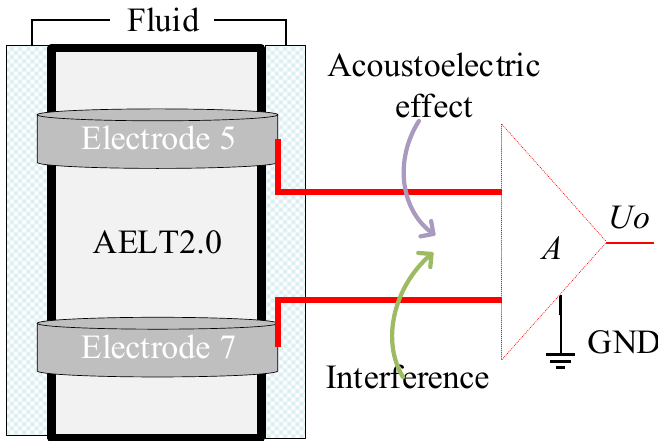
Figure 3. Schematic diagram of the electrodes and measurement circuits.